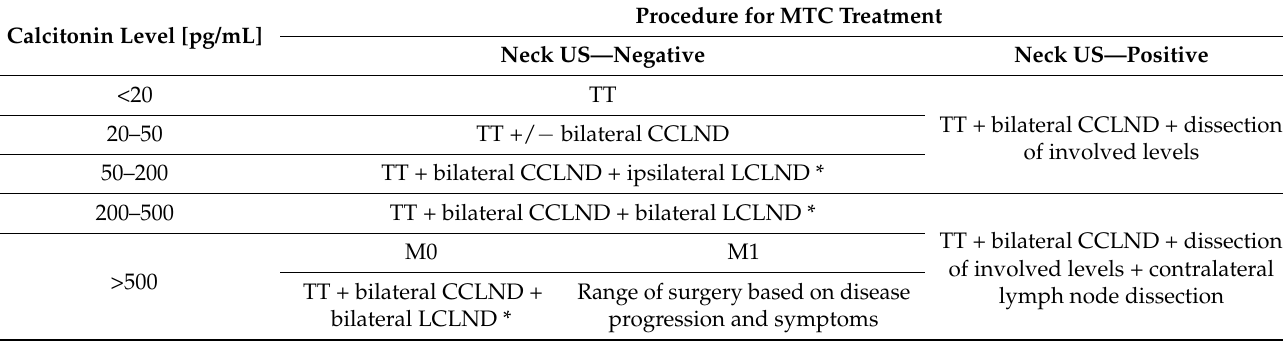
Table 4. Procedure for the treatment of medullary thyroid carcinoma based on the calcitonin level, as recommended by